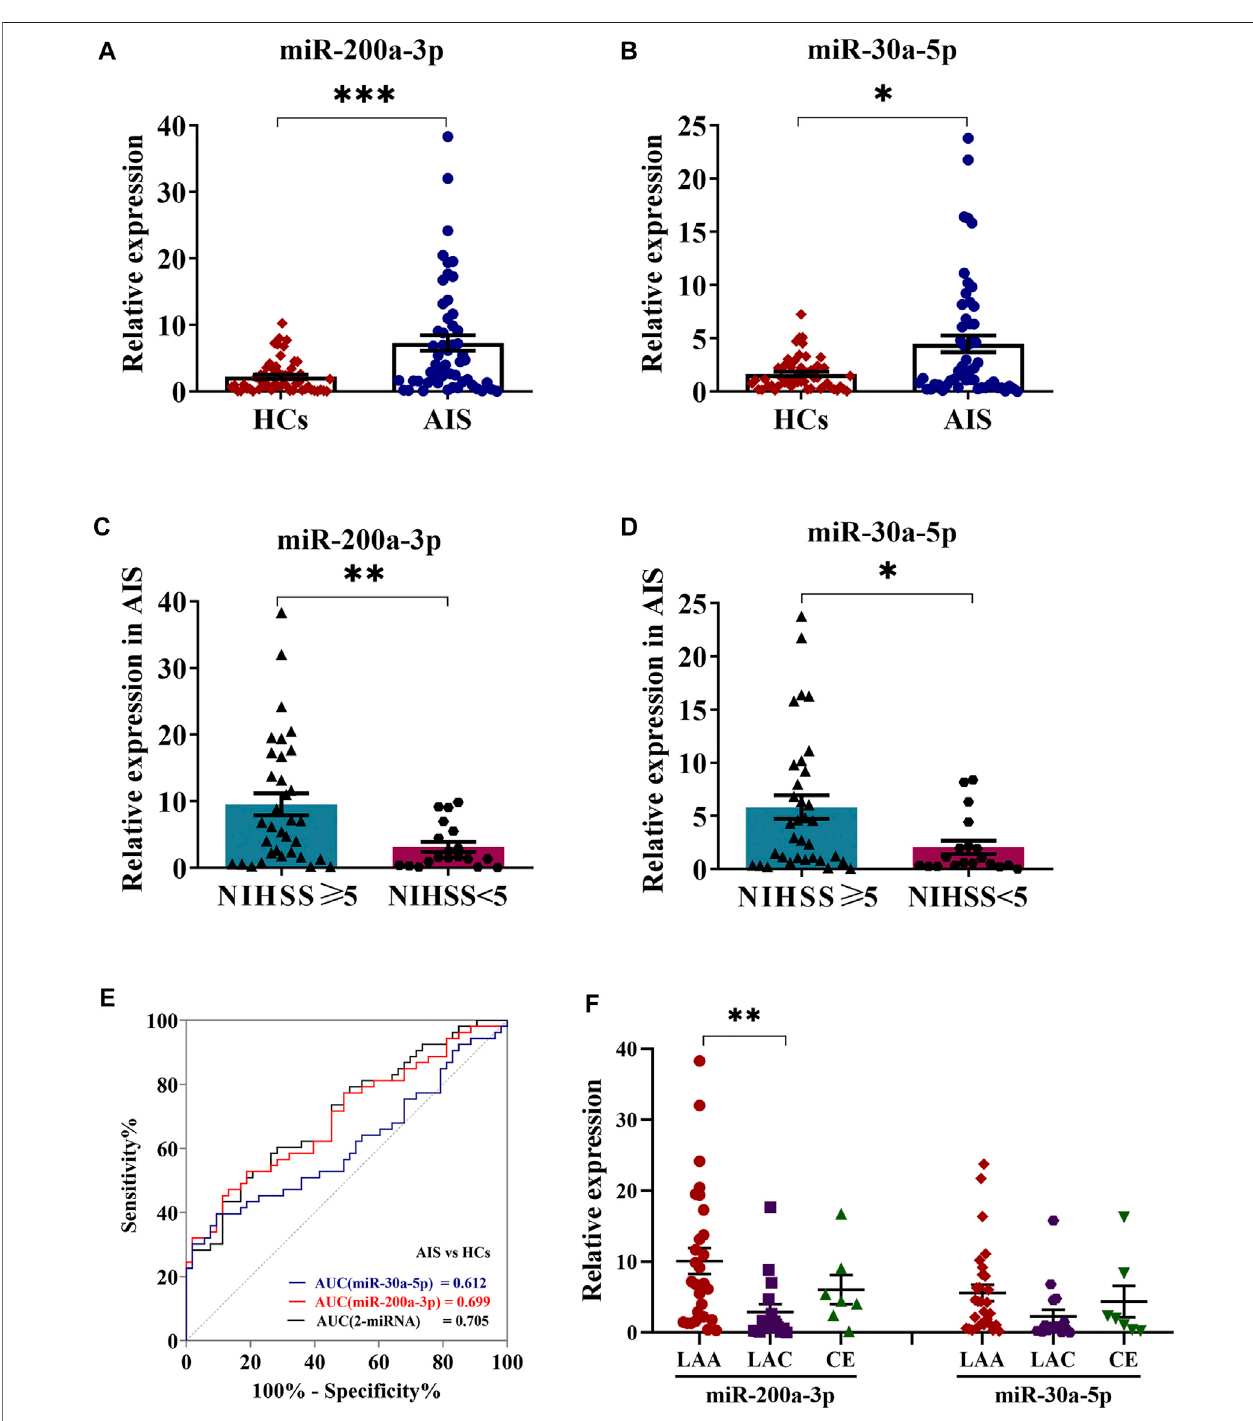
FIGURE2| ExpressionlevelsofmiR-200a-3pandmiR-30a-5pinplatelets. (A,B) QRT-PCRanalysiswasperformedtodetecttheexpressionofplateletmiR-200a- 3p and miR-30a-5p in the AIS patients ( n = 53) and HCs ( n = 53). (C,D) The expression levels of platelet miR-200a-3p and miR-30a-5p in AIS patients with moderate to severe neurological de fi cit (NIHSS ≥ 5, n = 27) and mild neurological de fi cit (NIHSS < 5, n = 26). (E) Diagnostic value of a microRNA set for AIS. ROC curves for the individual miRNAs and the combination index and their corresponding AUC values for discriminating AIS patients ( n = 53) from HCs ( n = 53). (F) One-way ANOVA followedbyTukey ’ spost-hocanalysiswasperformedtocomparemiRNAs(miR-200a-3pandmiR-30a-5p)differencesinAISpatientsbyTOASTclassi fi cation(LAA, n = 29;LAC, n =7;CE, n =17).Datawereexpressed asmean±SEM.DifferencesbetweenAISpatientsandHCs wereassessed bytheMann – WhitneyUtest, respectively, respectively, * p < 0.05, ** p < 0.01, *** p < 0.001.